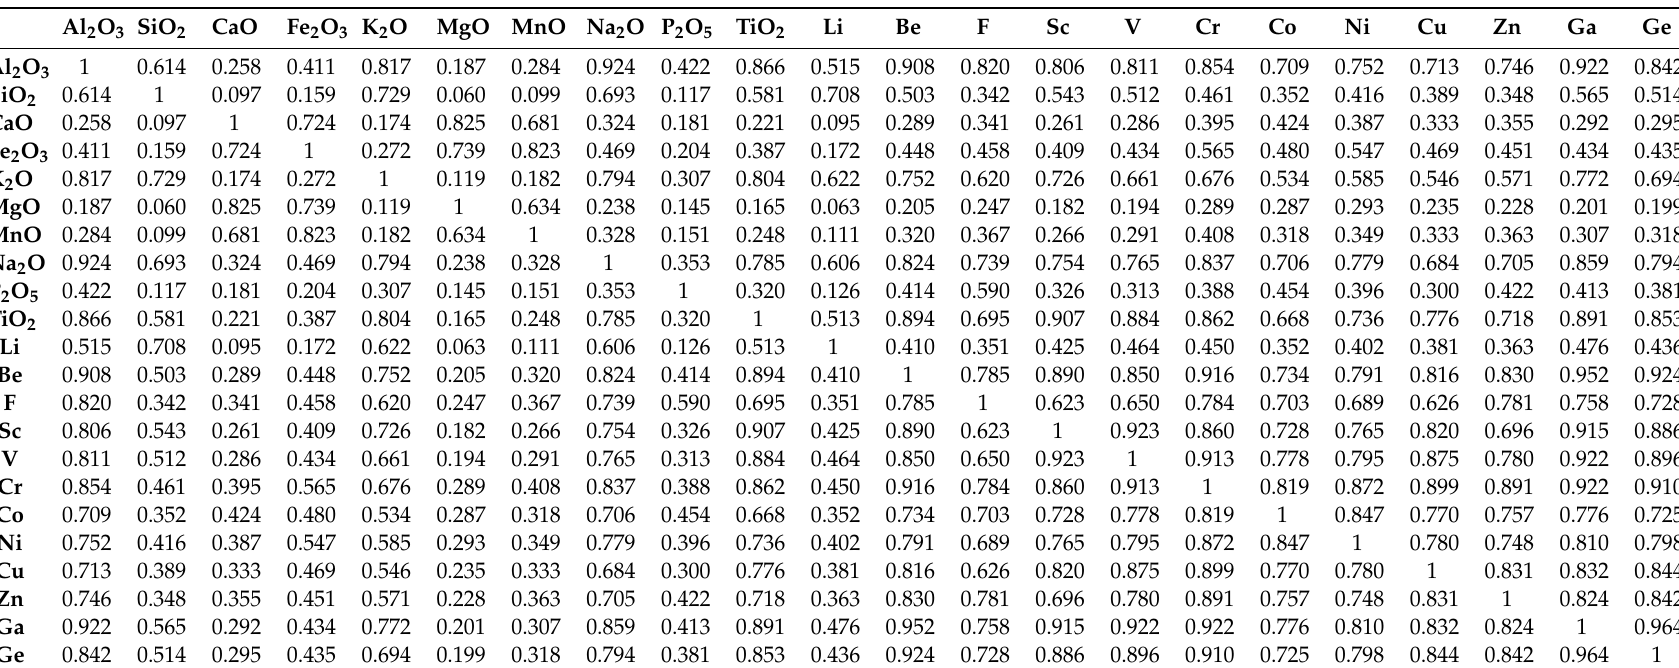
Table 5. Stability using Geboy’s approach on coal and ash basis (Adaohai